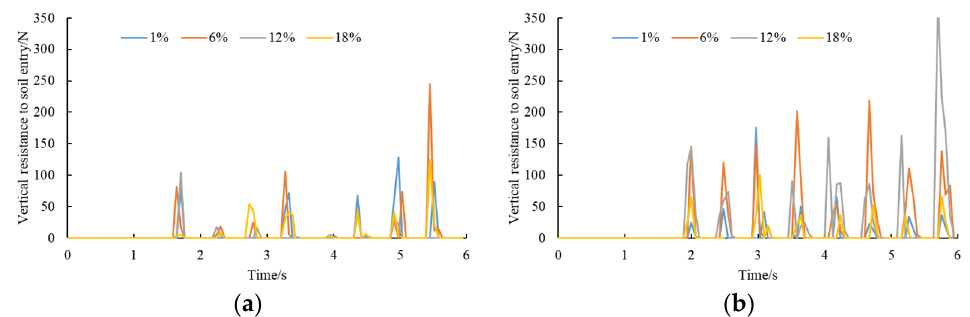
Figure 13. Entry resistance of the cavity seeder in sandy loam. ( a ) Left cavity seeder. ( b ) Right cavity seeder.